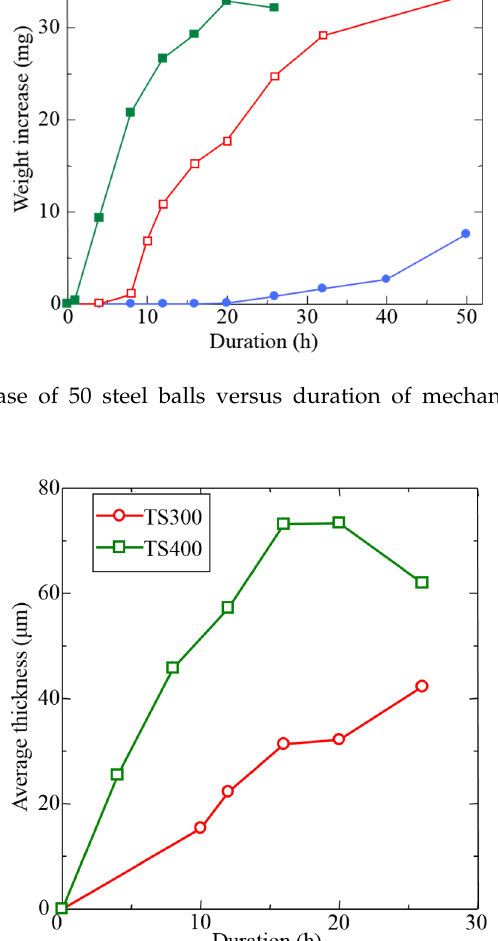
Figure 6. Average thickness of Ti coatings versus duration of mechanical coating at different revolution speeds.